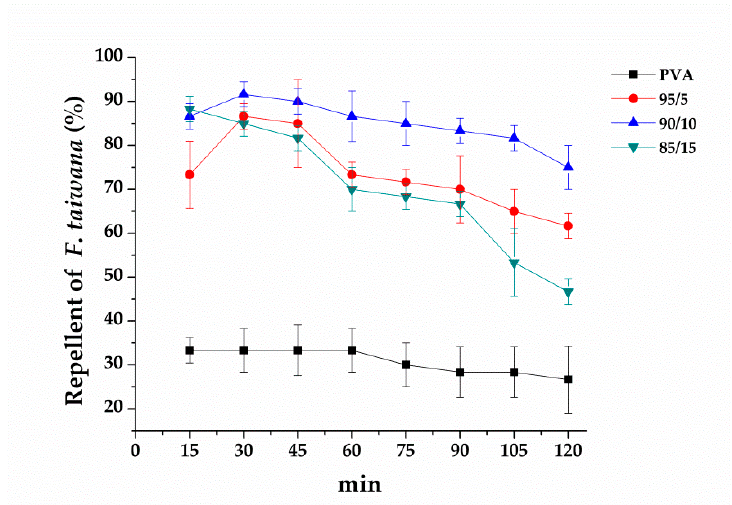
Figure 8. Repellent effectiveness of PVA/EGO nanofibrous membranes as related to the PVA/EGO ratios. The number of F. taiwana is 20 ± 3.